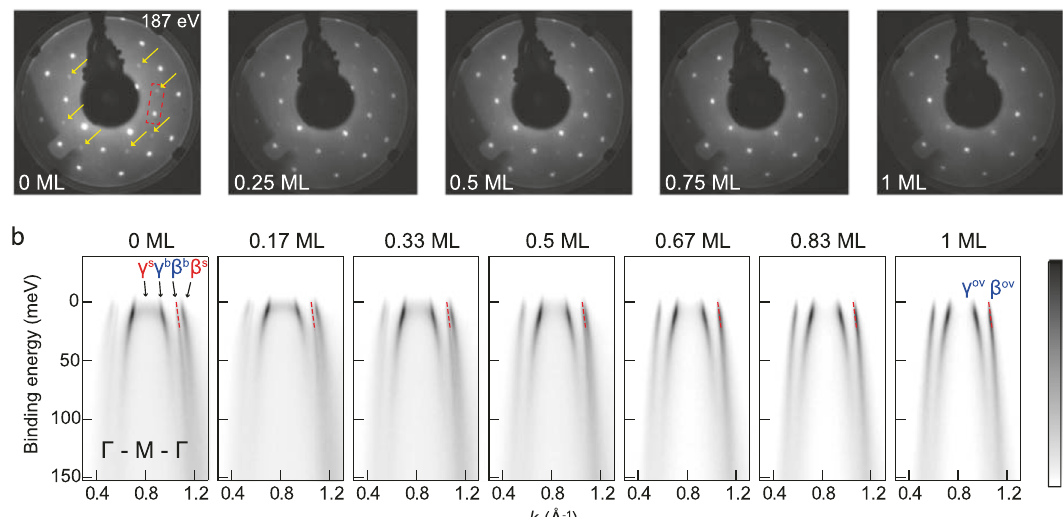
Fig. 2 Low-energy electron diffraction and angle-resolved photoelectron spectroscopy results according to the K coverage. a Electron diffraction images for various K coverages (0, 0.25, 0.5, 0.75, and 1 ML). The yellow arrows indicate peaks due to reconstruction; as the K coverage increases, these peaks gradually become weaker and eventually disappear. The rectangle in red is the region of quantitative intensity analysis in Supplementary Fig. 1. b Photoelectron spectroscopy images along Γ – M – Γ for various K coverages (0, 0.17, 0.34, 0.5, 0.67, 0.83, and 1 ML). Red dashed lines are to mark the position of β b of 0 ML